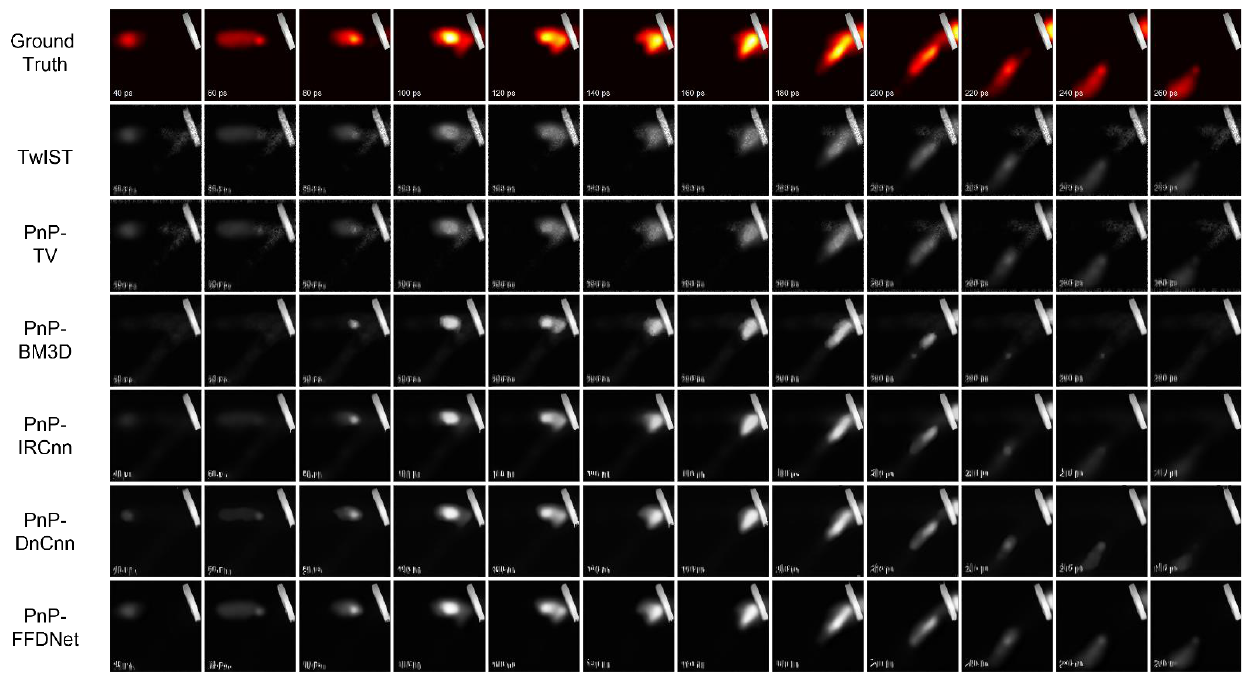
Figure 12. Reconstruction performance of different reconstruction algorithms on real data.